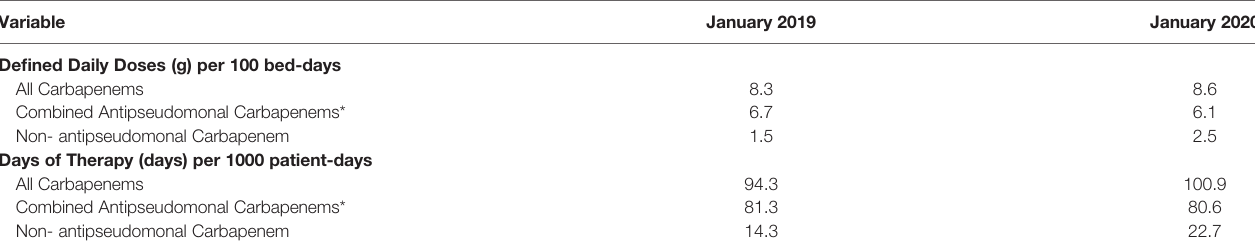
TABLE 4 | Carbapenem-speci fi c de fi ned daily doses (DDD) And days of therapy (DOT) in January 2019 and January 2020. Variable